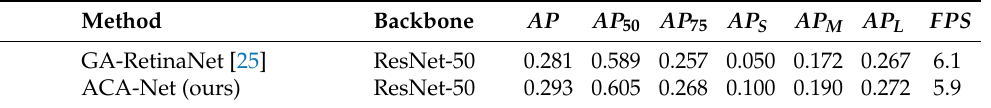
Table 4. Comparison